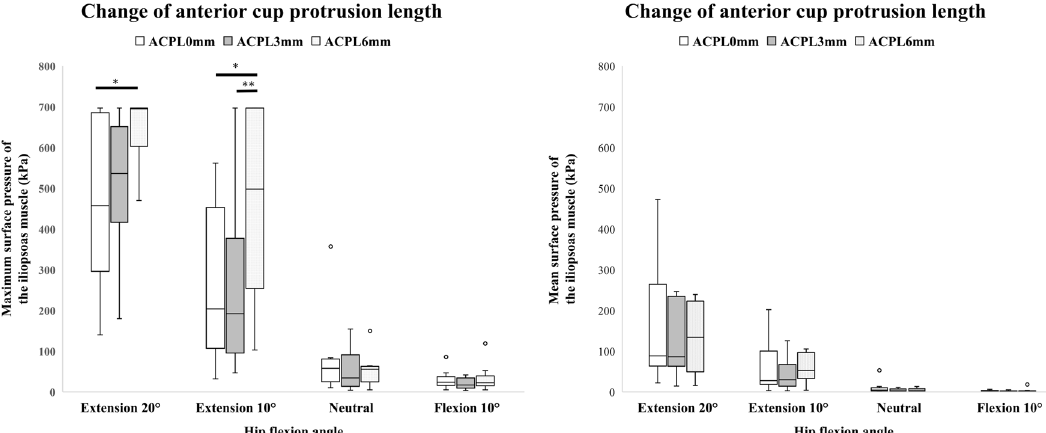
Figure 2. Maximum and mean surface pressure of the iliopsoas muscle when the anterior cup protrusion length (ACPL) was changed. * p < 0.05, ** p < 0.01.